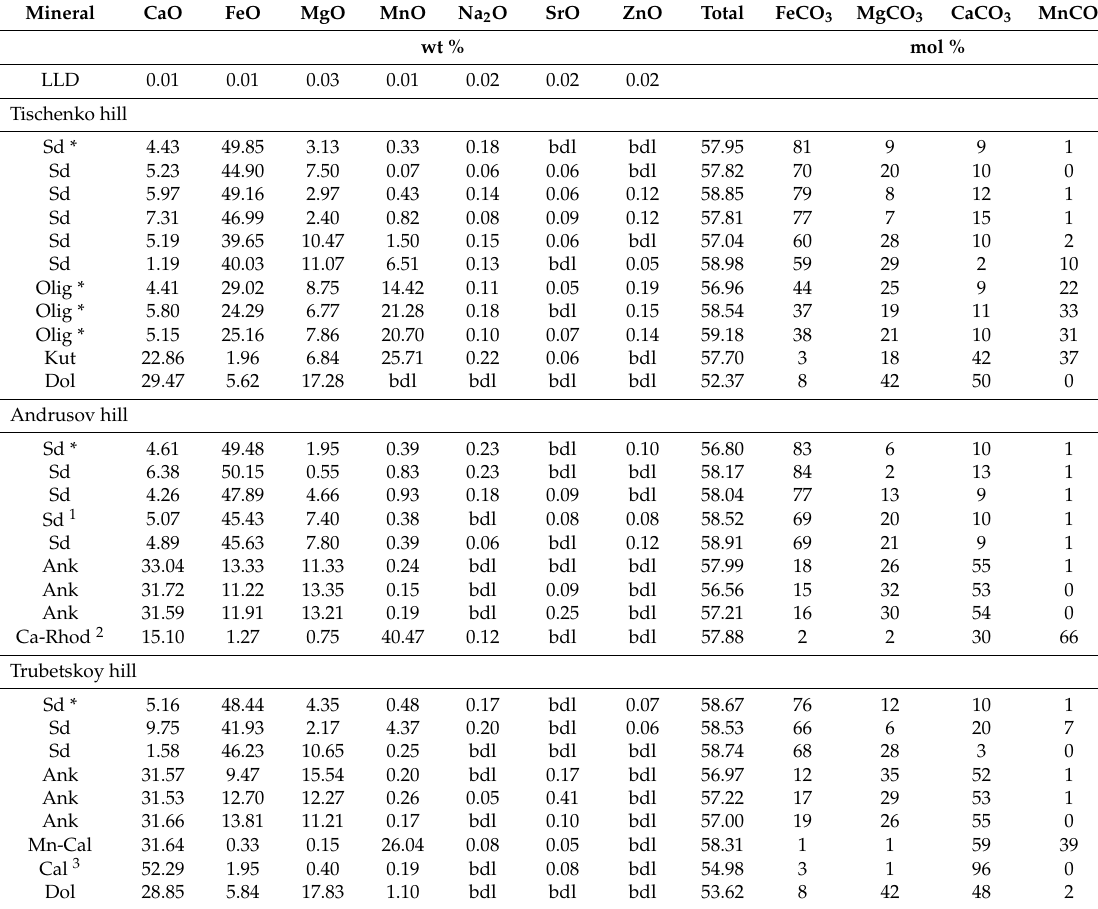
Table 4. Representative EMPA analyses of authingenic carbonates from mud